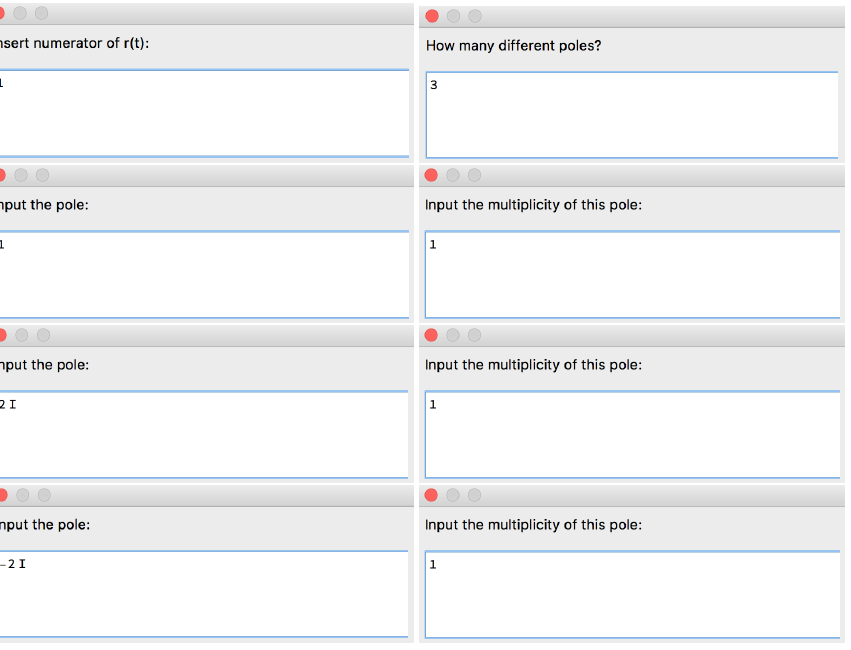
Figure 49. Part of the structure of the [ASPPlusPMinus] algorithm corresponding to Option 2 to input r . [ASPPlusPMinus] algorithm gives the output presented in Figure